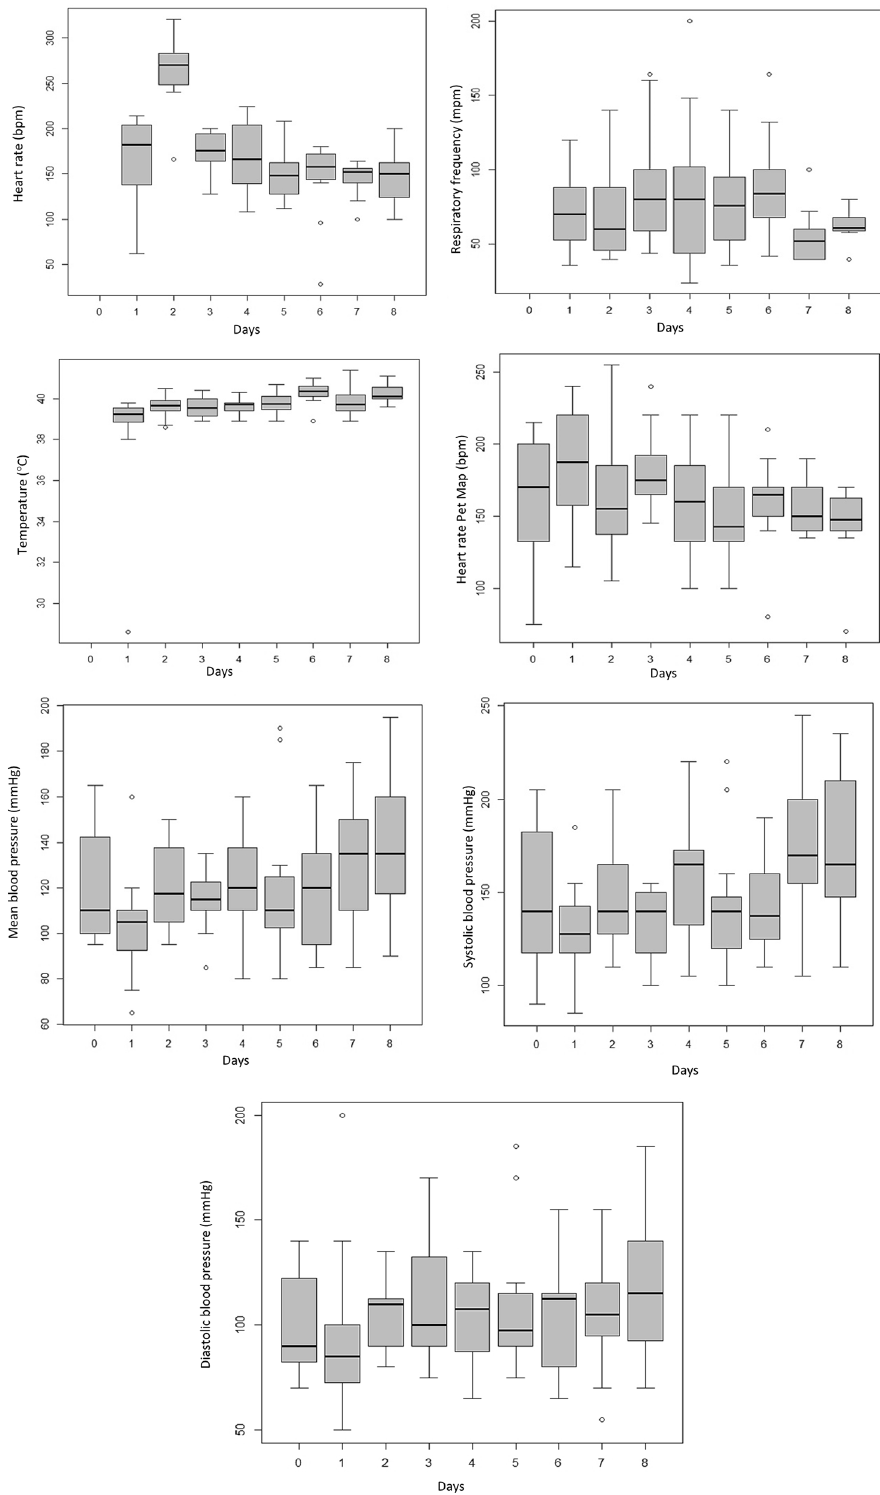
Figure 1. Clinical examination parameters during the neonatal period up to 120 days of age in Dorper